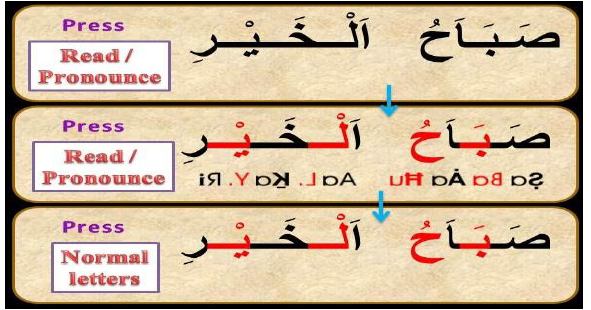
Figure 11. Displaying reversed phonetics right to left